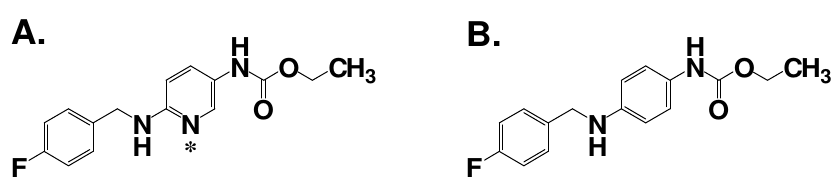
Figure 1. A . Flupirtine; B . Retigabine. Asterisk denotes basic